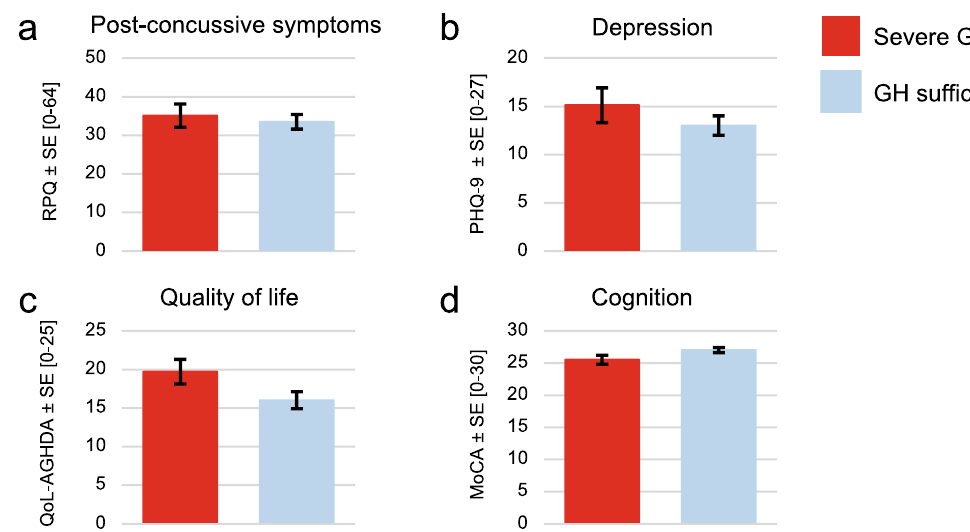
Figure 3. Clinical outcomes and response to dynamic testing. Participants dichotomized as severe GHD (peak GH < 3 µg/L) or GH sufficient (peak GH ≥ 3 µg/L). ( a – c ) Symptom burden (RPQ) (n = 48), depression (PHQ-9) (n = 60) and quality of life (QoL-AGHDA) (n = 28) scores were higher in individuals with severe GHD, however this was not statistically significant. Higher Qol-AGHDA scores indicate worse quality of life. ( d ) Cognition (MoCA) (n = 57) scores were lower in individuals with severe GHD, however this was not statistically significant. GH growth hormone, GHD growth hormone deficiency, MoCA Montreal Cognitive Assessment, PHQ-9